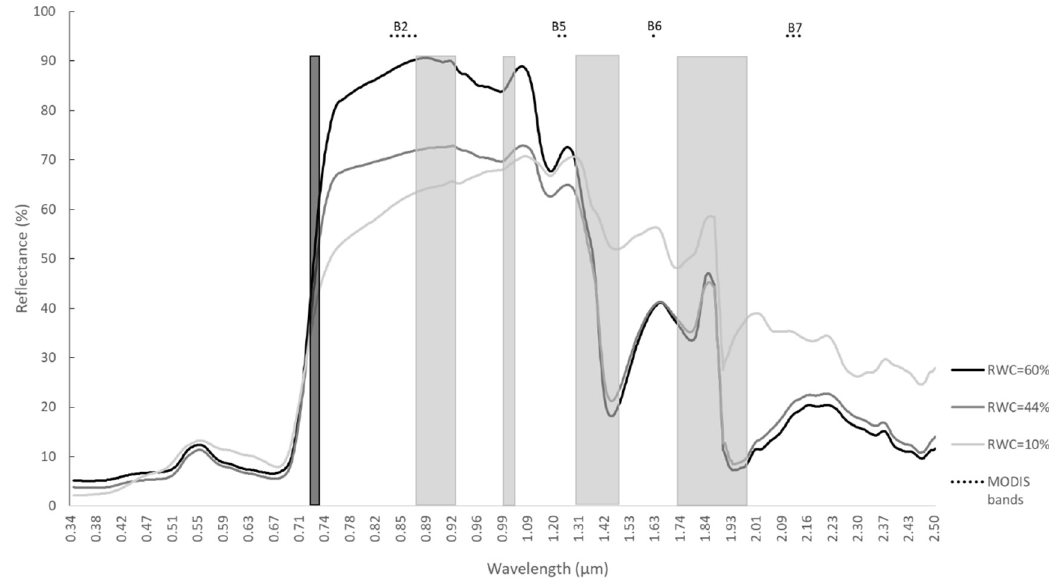
Figure 5. Reflectance spectra for soybean leaves with different water content. The intervals of strong atmospheric water vapor (grey rectangles), MODIS bands, and oxygen absorption (black rectangle) are included.